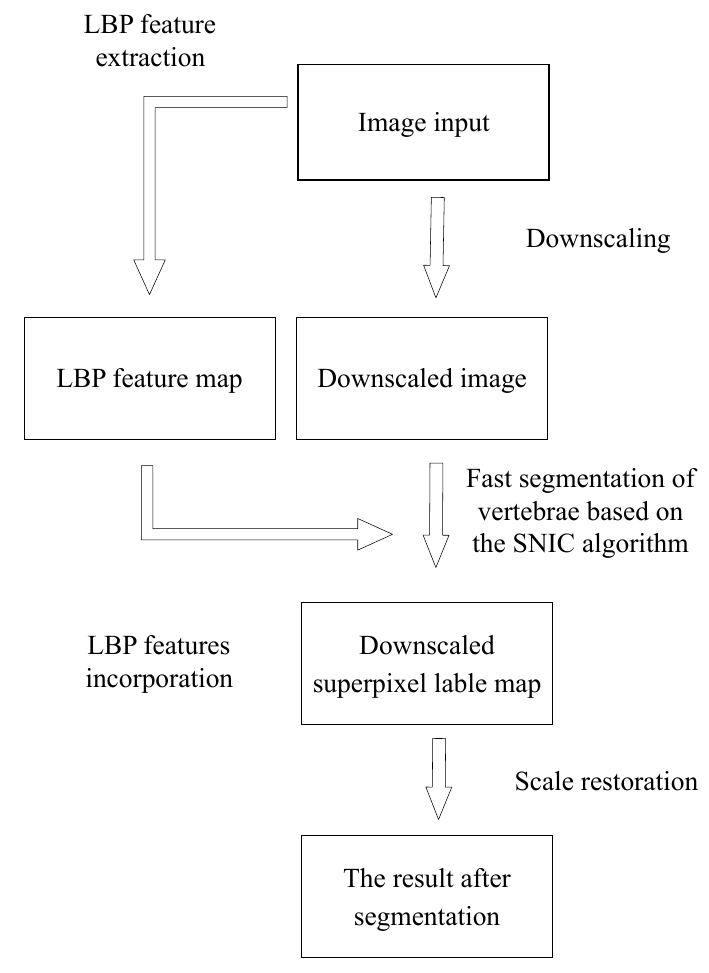
Figure 5. Improved SNIC algorithm flow